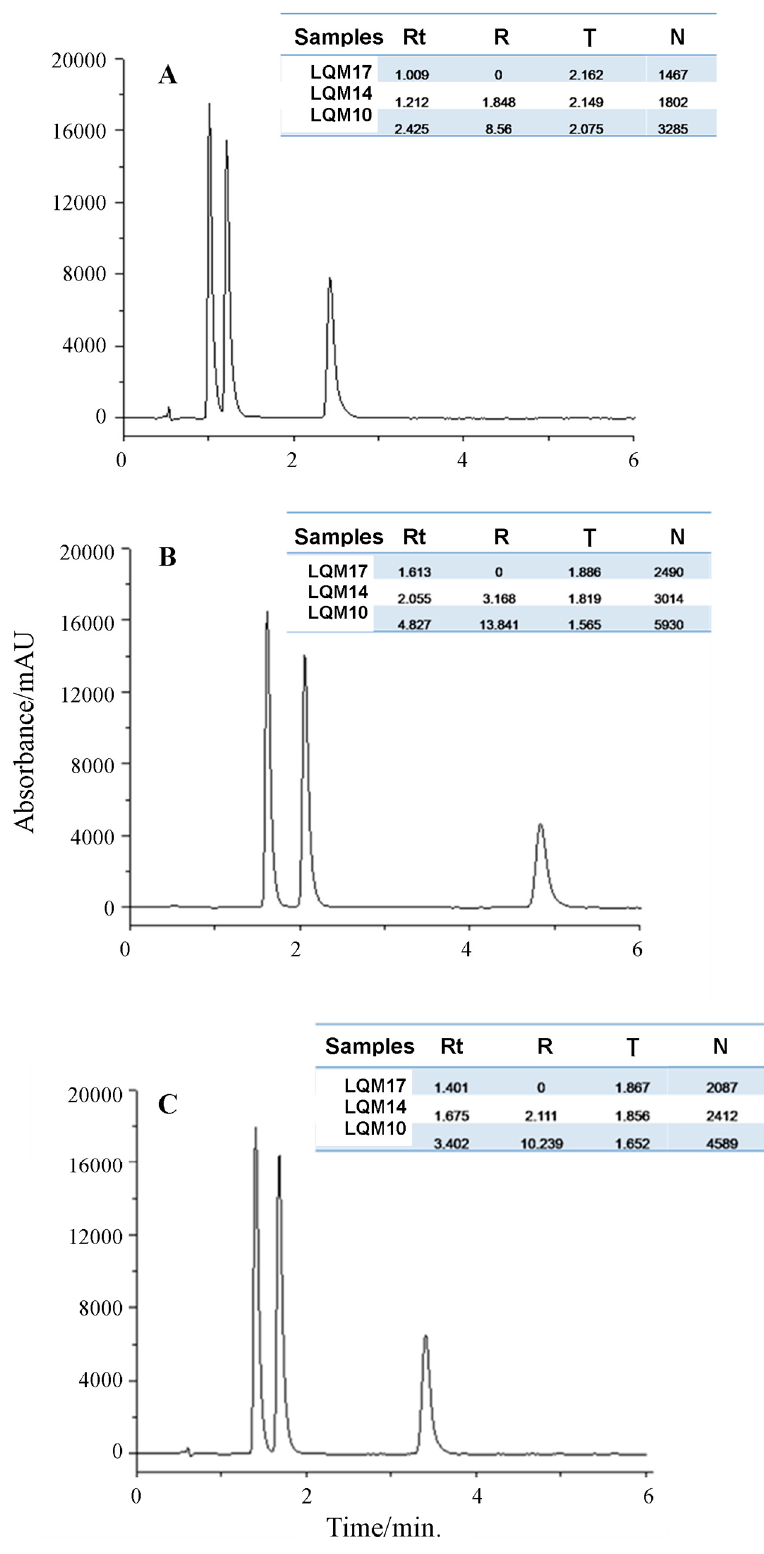
Figure 5. Chromatograms of the best UHPLC method obtained under different conditions to mobile phase composition: ( A ) MeOH:H 2 O (60:40) pH 3.5; ( B ) MeOH:H 2 O (60:40) + 0.1% TEA and ( C ) MeOH:H 2 O (65:35) + 0.1% TEA. Column length: 50 mm; the mobile phase flow rate: 0.5 mL·min − 1 ; UV detection wavelength: 290 nm.